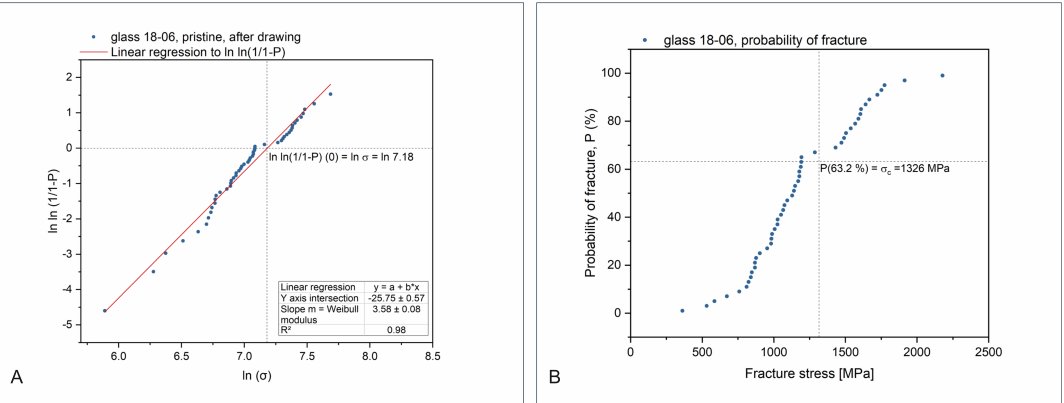
Figure 2. ( A ) Weibull statistics, the Weibull modulus (slope of the regression line) was determined as 3.58; ( B ) Plot of the probability of fracture P against the fracture stress